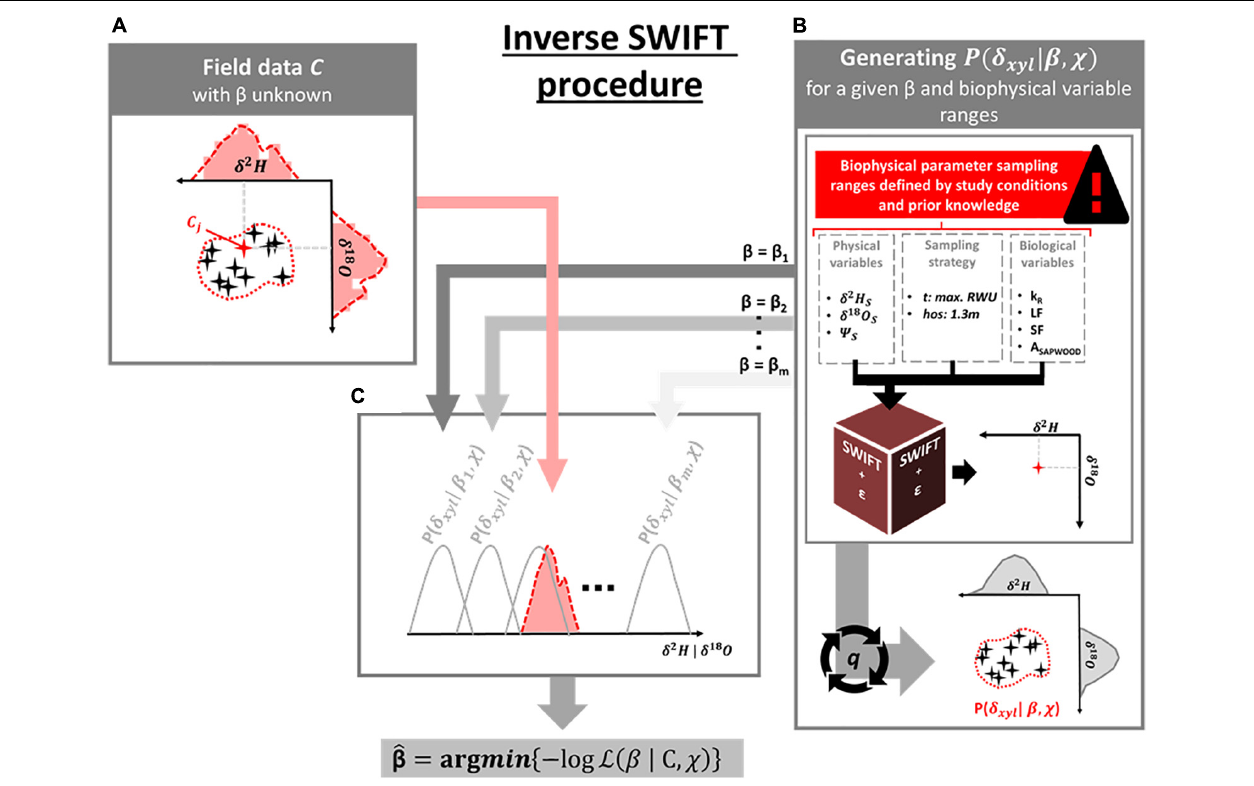
FIGURE 1 | Schematic overview of the Inverse SWIFT procedure which supports estimation of the plant groups’ mean allocation parameter β (which defines the exponential vertical decay of the distribution of absorbing root surface with soil depth) from the respective xylem water isotopic compositions [( δ xyl ; being δ 2 H and/or δ 18 O , subplot (A) ]. Specifically, a model that couples a standard multi-source mixing model with a mechanistic plant hydraulic model, e.g., the SWIFT model, allows for the generation of theoretical xylem water isotopic field data for a given β and a set of biophysical model variables ( χ ) (B) . In this way, conditional density probability distributions ( P ( δ xyl | β , χ )) are established for a range of β -values to which field data C can be matched (C) . The β -value which correspond to the ( P ( δ xyl | β , χ )) which minimizes the log-likelihood function provides the best β -estimate ( b β ) of the studied plant